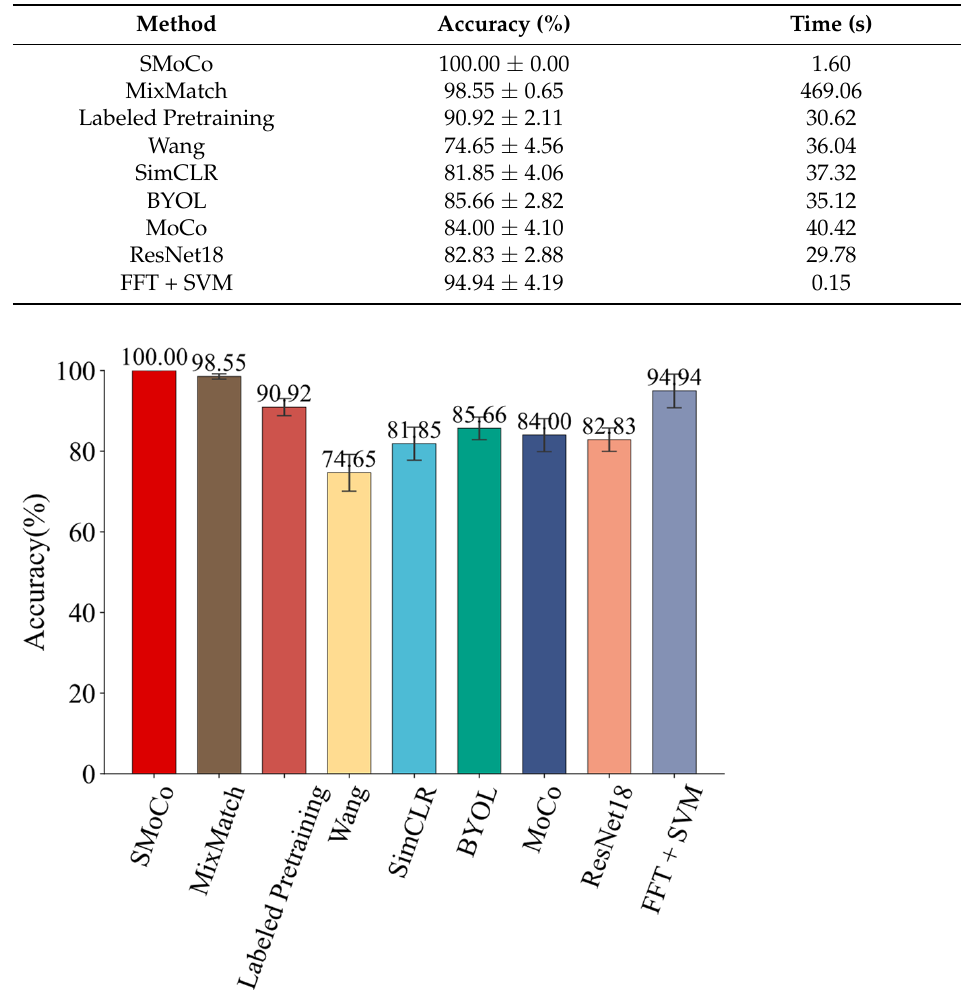
Table 7. Comparison of diagnostic results on dataset 3 under 3 samples per class.